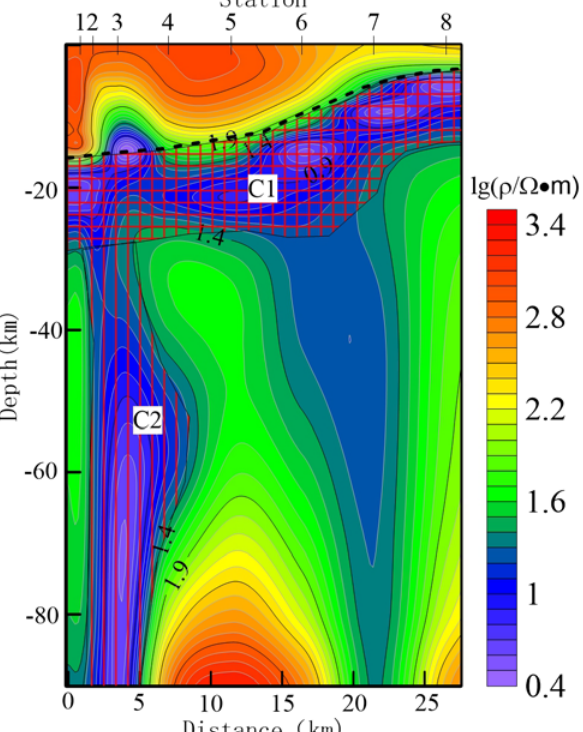
Figure 7. 1D Occam inverted section used equivalent apparent resistivity data. C1 and C2 are the abnormal area of high